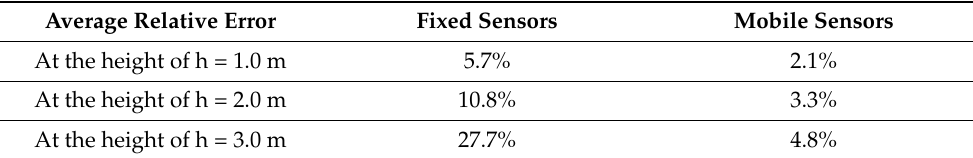
( a ) Prediction at the height of 1.0 m using fixed sensors and mobile sensors